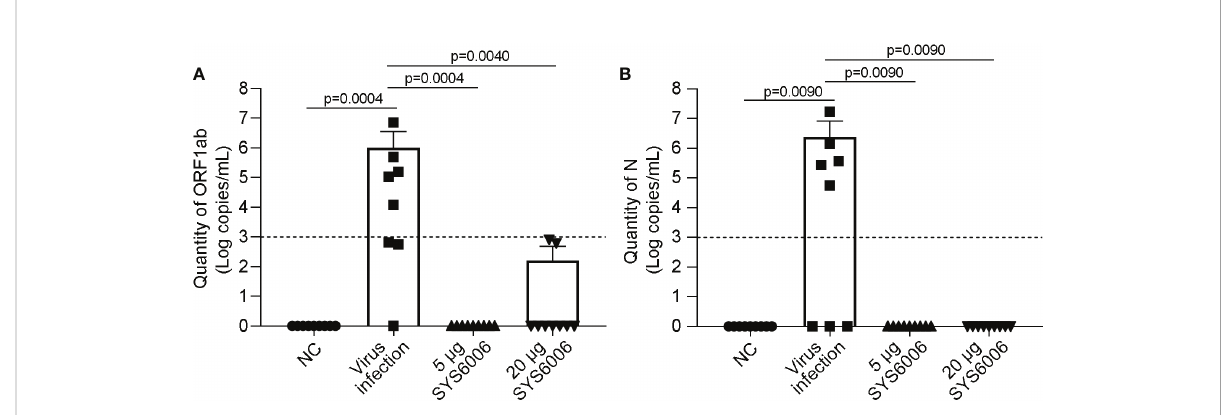
FIGURE 7 The viral loads in the lung tissues of hACE2 transgenic mice under the infection with Delta variant. 6-8-week-old female hACE2 transgenic mice were immunized intramuscularly with SYS6006, boosted with the same dose on day 21 after the initial immunization, and intranasally infected with live-virus of Delta variant on day 12 after boost vaccination. Lung tissues were collected 7 days after virus infection and tested for the quantities of ORF1ab (A) and N (B) RNAs by RT-qPCR. NC means the control mice without immunization and virus infection. “ Virus infection ” group represents the mice did not receive vaccination but were infected by live virus. “ 5 m g SYS6006 ” and “ 20 m g SYS6006 ” groups mean the mice were vaccinated with 5 m g and 20 m g of SYS6006 respectively, and then infected by live virus. The dot line indicated the detection limit of Real-time PCR (1000 copies/mL virus RNA and cycling threshold (CT) =35). Data are presented as mean ± SD. ACE2, angiotensin-converting enzyme